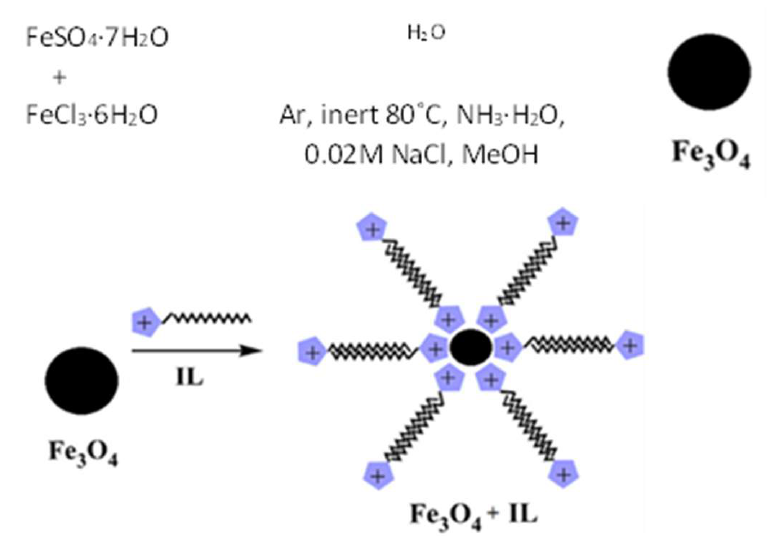
Figure 1. Scheme of synthesis of MNPs and their paramagnetic properties. Table 1. Chemical structure and typical chromatograms of targeted polycyclic aromatic hydrocar-